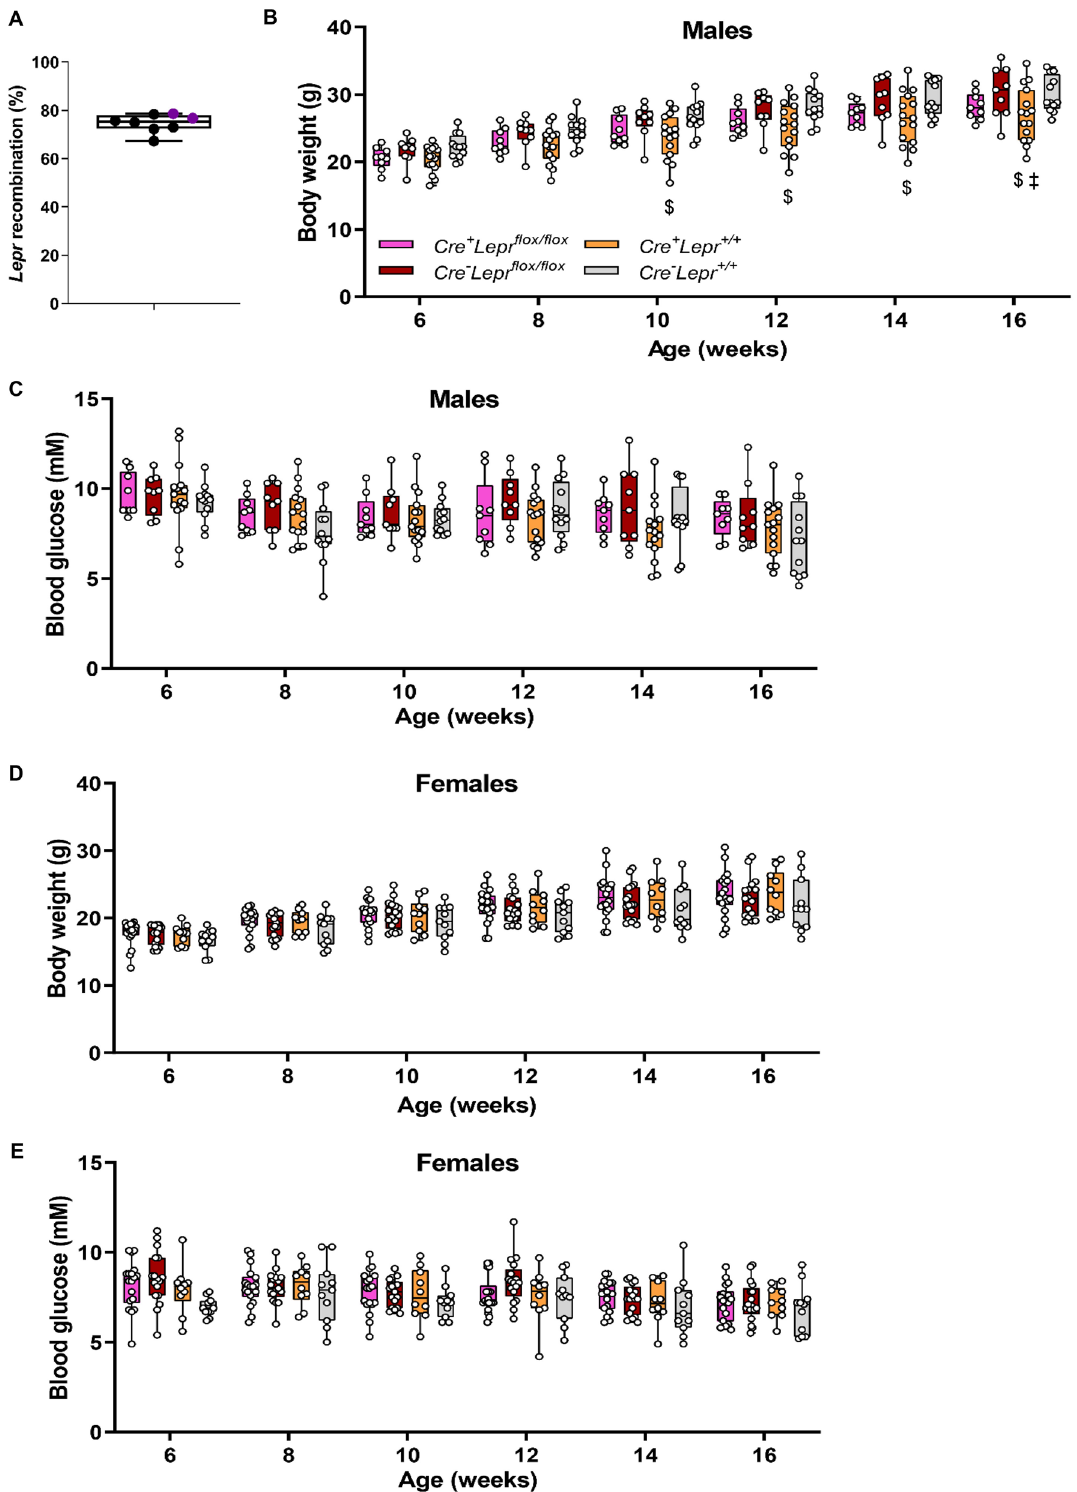
Figure 7. Recombination in bone marrow-derived macrophages of mice from the Lepr knockdown study; male mice are represented by black circles and female mice are represented by purple circles ( A ). Body weight ( B , D ) and blood glucose ( C , E ) of mice from the Lepr knockdown study at different ages; parameters obtained after a 4 h fast. In ( B ) and ( C ), n = 9 for Cre + Lepr flox/flox , n = 9 for Cre − Lepr flox/flox , n = 15 for Cre + Lepr + / + , and n = 12 for Cre − Lepr + / + . In ( D ) and ( E ), n = 18 for Cre + Lepr flox/flox , n = 17 for Cre − Lepr flox/flox , n = 10 for Cre + Lepr + / + , and n = 11 for Cre − Lepr + / + . Performed repeated measures two-way ANOVA with post-hoc analysis in ( B – E ). $ p < 0.05, Cre + Lepr + / + vs. Cre − Lepr + / + ; ‡ p < 0.05, Cre − Lepr flox/flox vs. Cre + Lepr + / + . Main effect of time (p < 0.05) in ( B – E